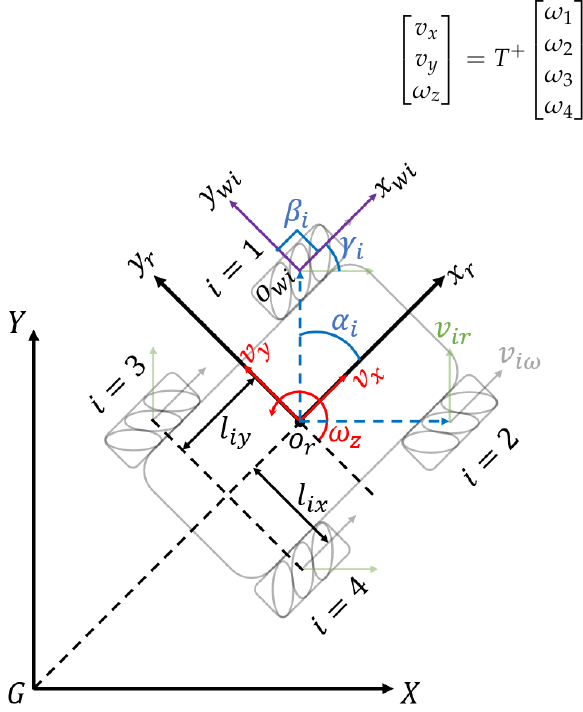
Figure 5. Kinematics model of Wasp